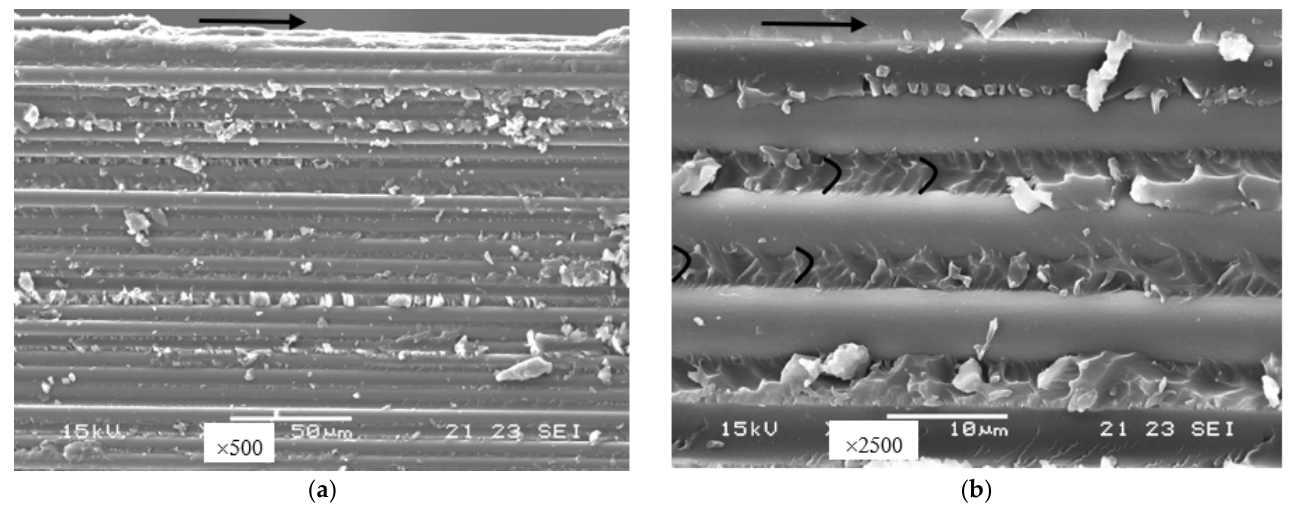
Figure 14. The tensile fracture modes in the holed 0° coupons with different diameters; ( a ) general view; ( b ) 5.5 mm; ( c ) 8 mm (the dashed circles indicate the zone where the fracture occurred).